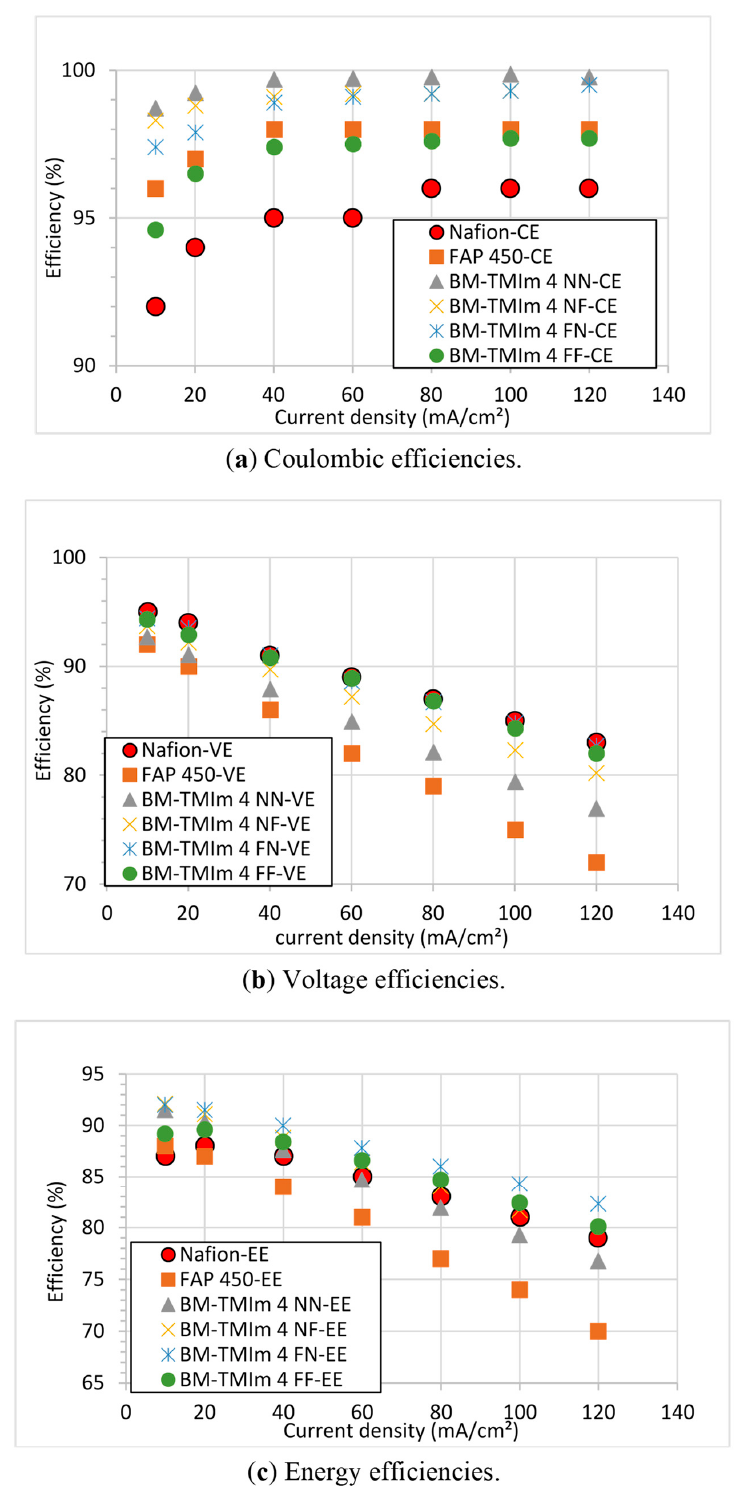
Figure 6. CE ( a ), VE ( b ) and EE ( c ) of studied membranes.